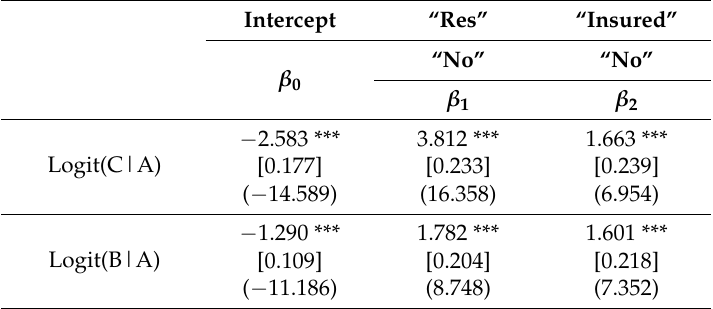
Table 2. Estimation for probability of distress on residency and insurance of patients.